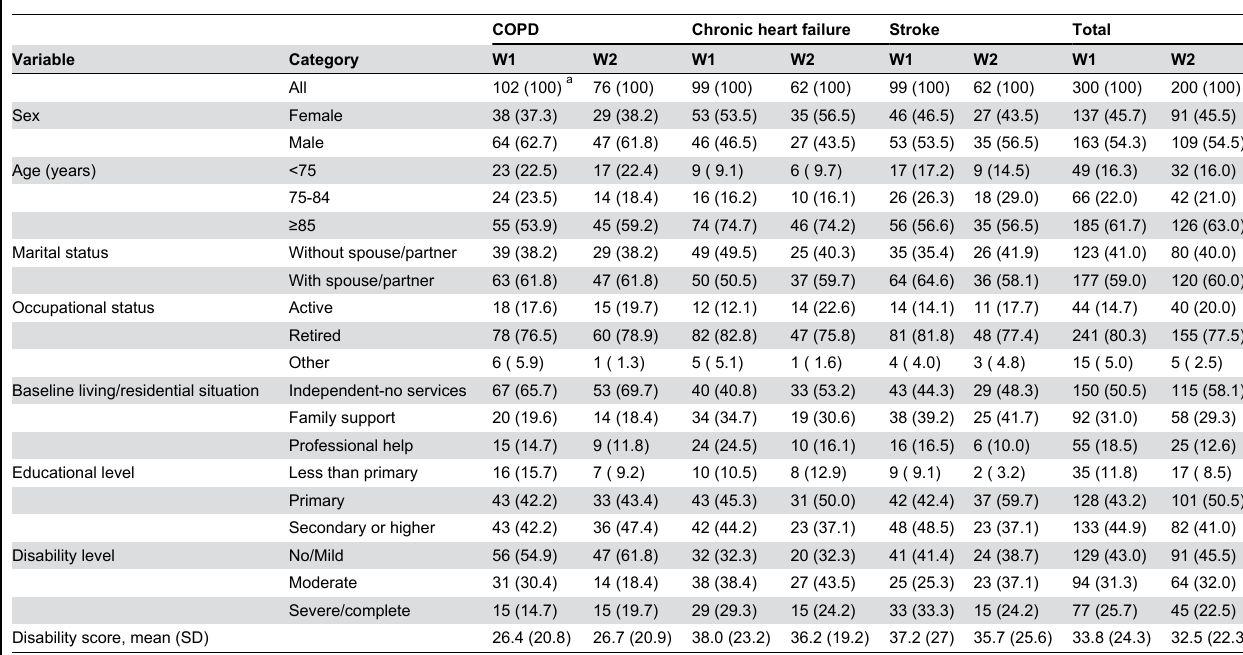
Table 1. Descriptive information by diagnostic group and